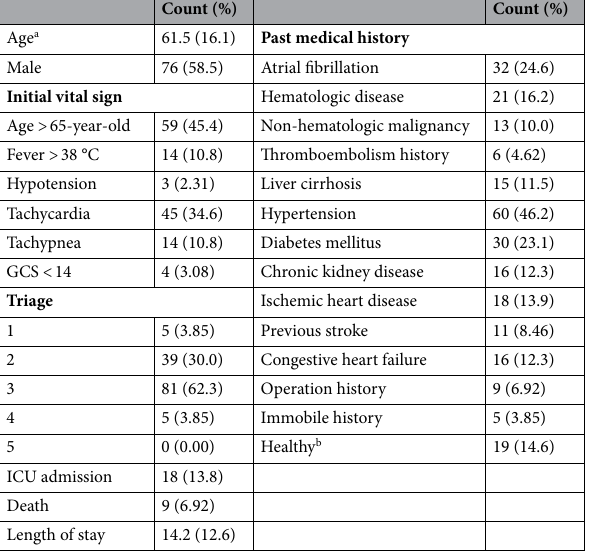
Table 1. Descriptive results of the patients with splenic infarction. a Presented as mean (SD). b If the patients did not have any medical history or comorbidities and did not take any medication, they will be classified to “healthy”.